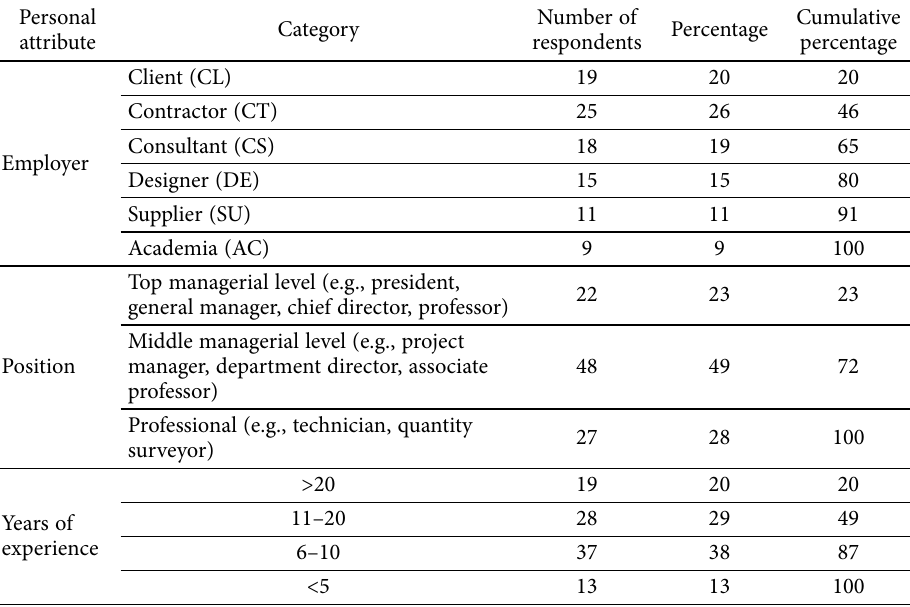
Table 4. Profile of questionnaire